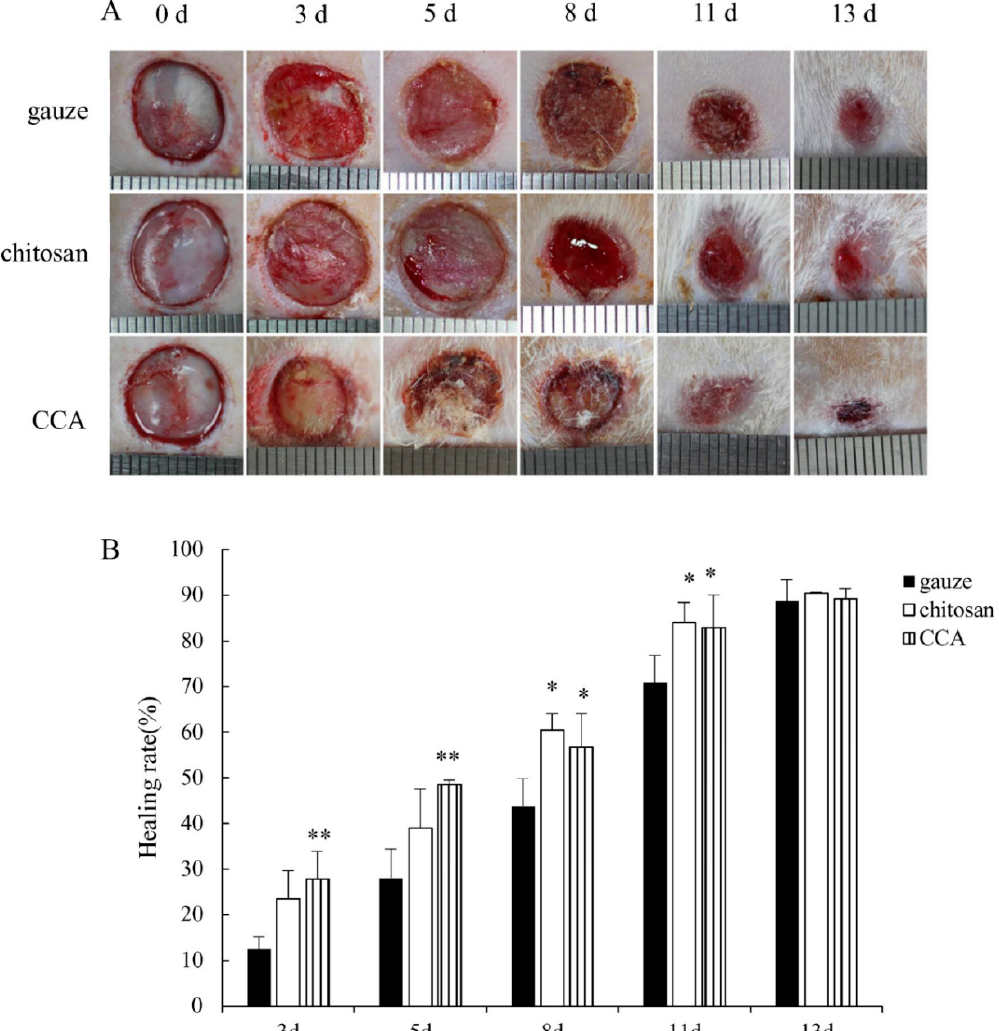
Figure 5. In vivo performance of chitosan-based composites. ( A ) Application of wound dressing platforms with improved properties and performance. The bilayered film/scaffold can be loaded with more than one drug due to the presence of two ionic polymers. The nano/microparticles could also be loaded with more than one drug, and the use of particles would enable the filling of the wound area. ( B ) The wound healing effect of the chitosan-collagen-alginate complex. Wound images were adjusted to the same scale, thereby allowing for a calculation of the wound area. The wound healing rate was calculated by employing the following equation: wound healing rate = ( S 0 − St )/ S 0 × 100%, where S 0 represents the area of the original wound and S t represents the area of the wound at the testing time (days). Image reproduced with permission from Xie et al. [48] .